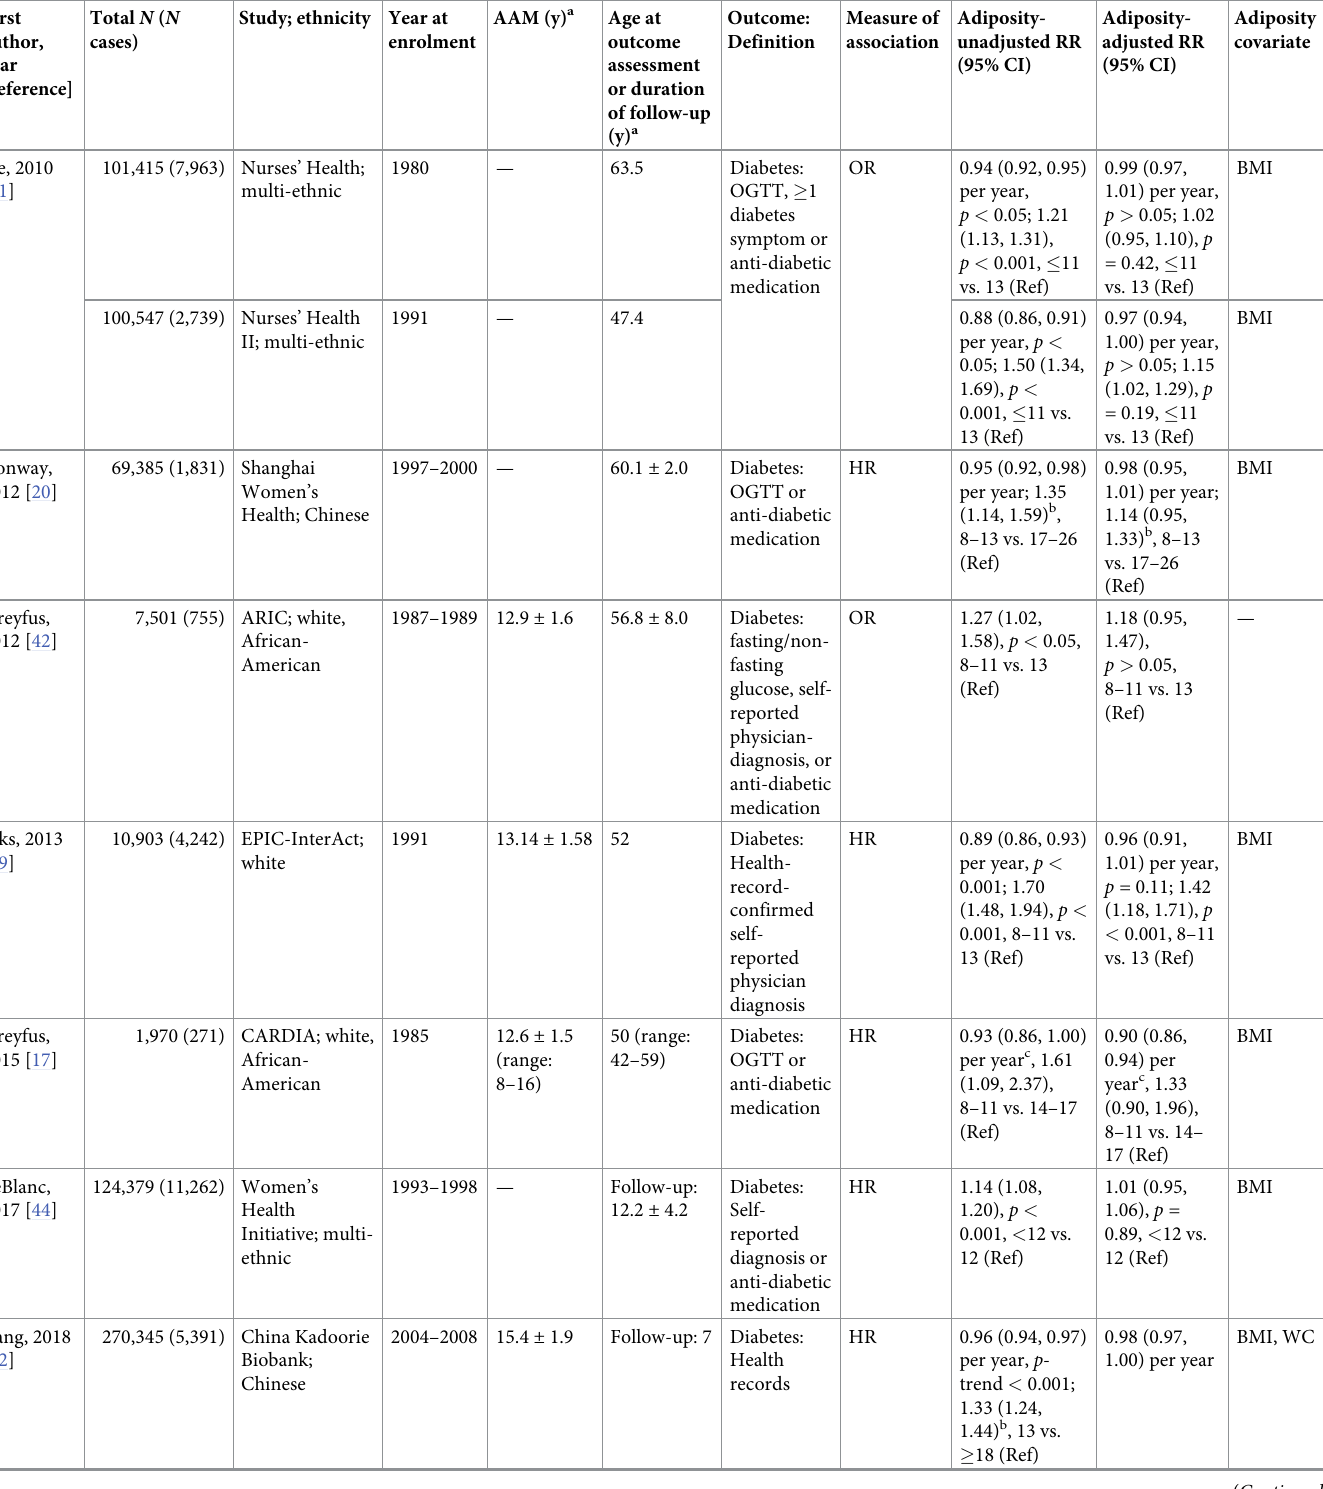
Table 2. Summary of eligible studies of incident